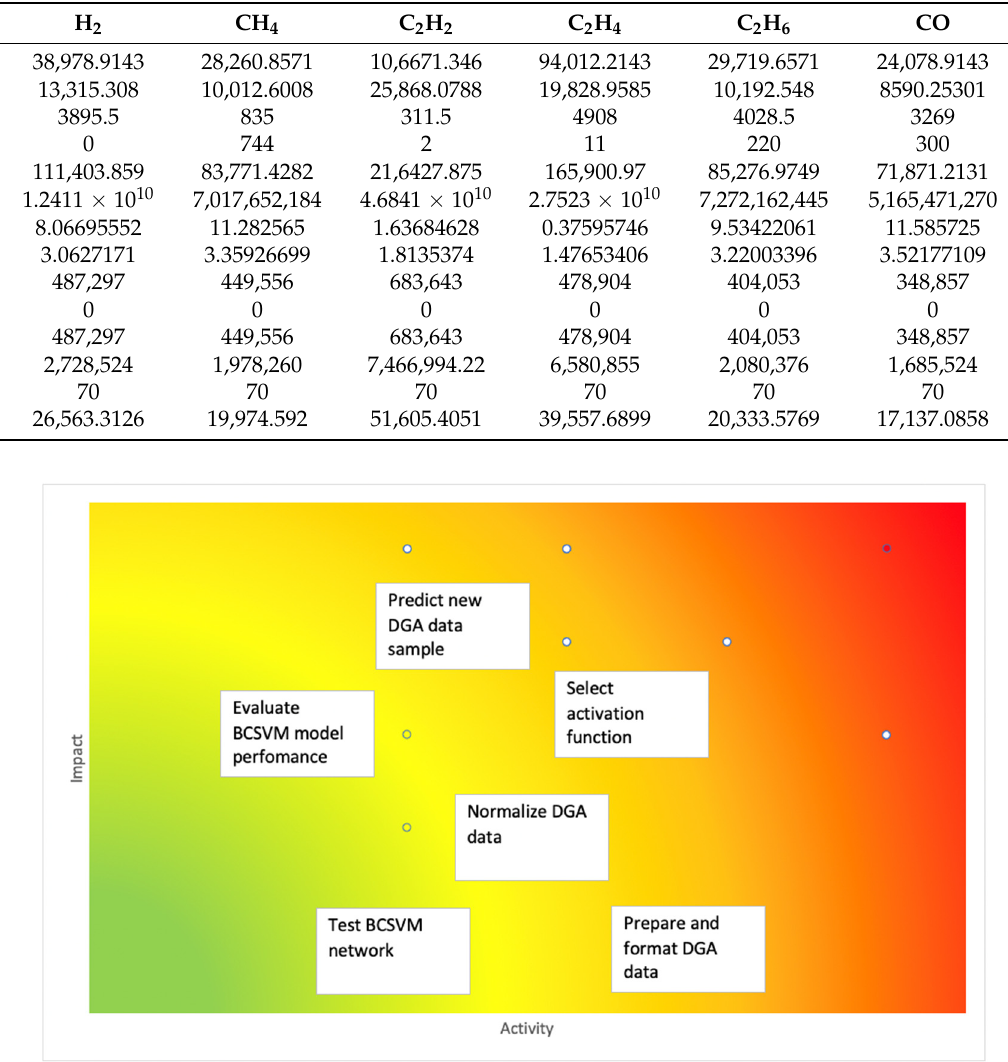
Table 3. Descriptive statistics sensitivity analysis of input gases.